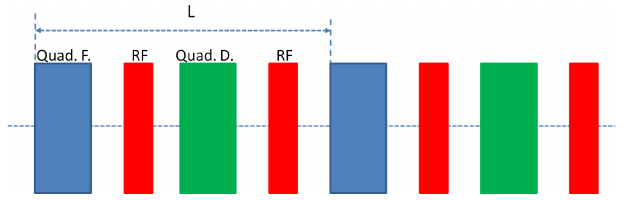
FIG. 7. Schematic plot of a periodic quadrupole and rf